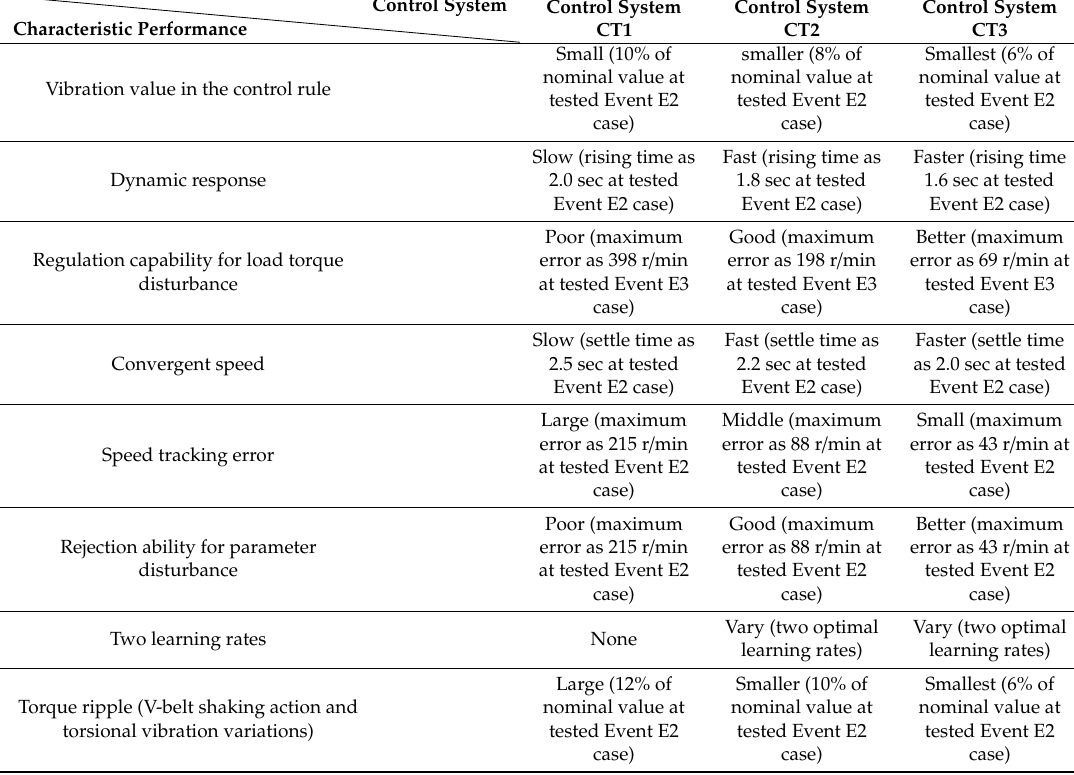
Table 2. Characteristic performance comparisons of control